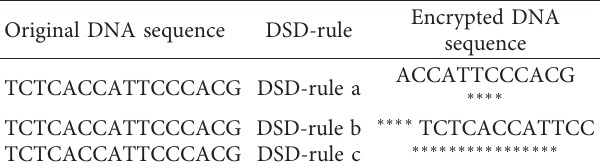
Table 2: DSD-based encryption rules. Original DNA sequence DSD-rule